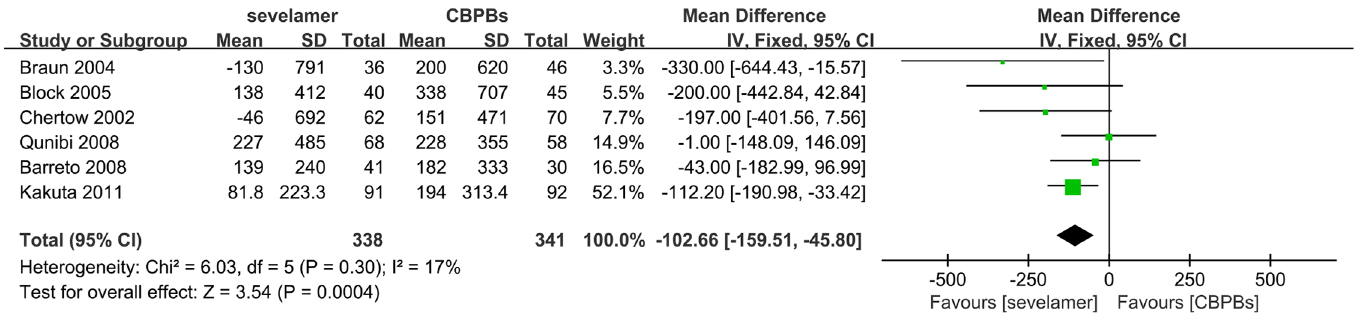
PLOS ONE | DOI:10.1371/journal.pone.0133938 July 31,